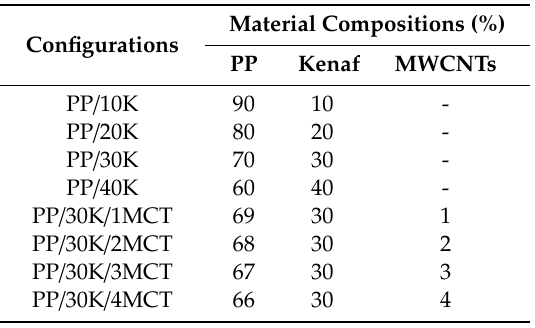
Table 1. Configurations of composites. MWCNTs: multiwalled carbon nanotubes, PP: polypropylene. Material Compositions (%) Configurations PP Kenaf MWCNTs PP / 10K